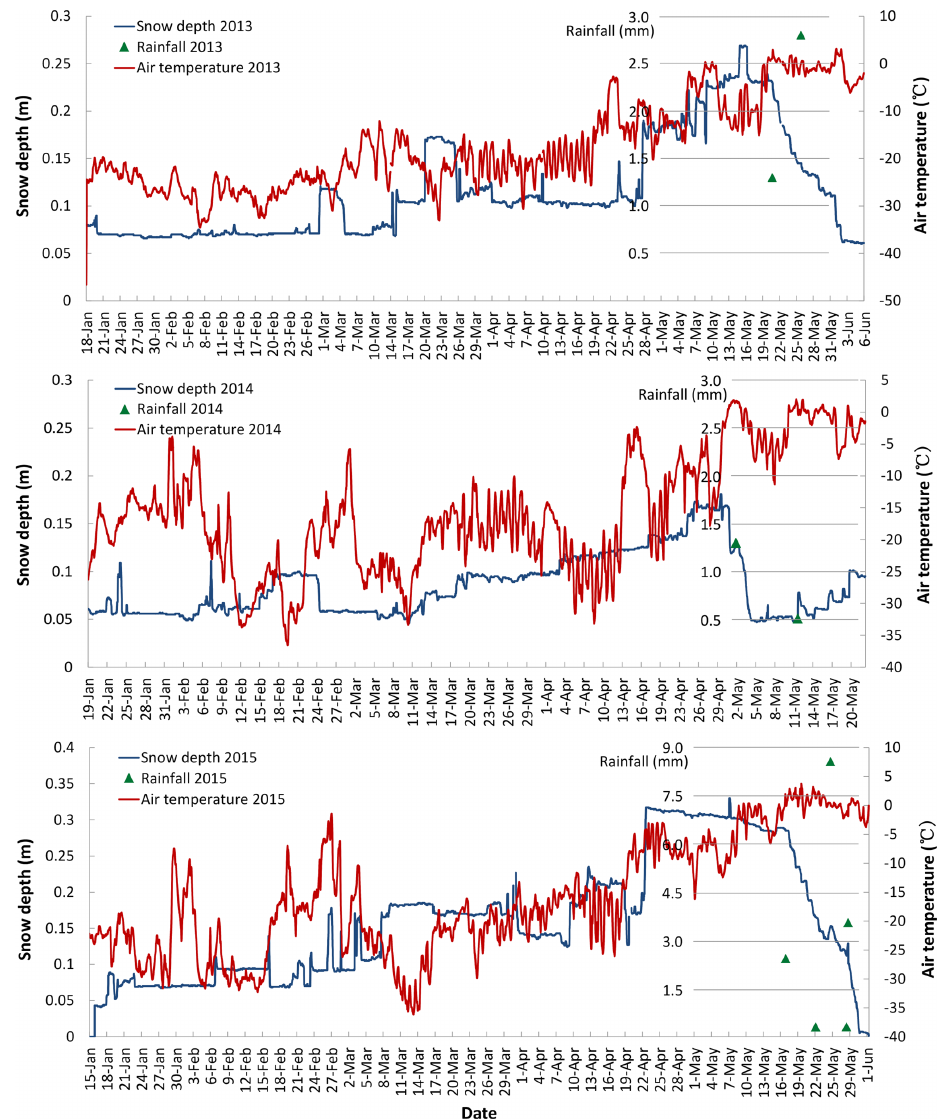
Figure 1. Rainfall and variations in air temperature and snow depth recorded near Utqia˙gvik, Alaska. The data were observed at the MB site on Chukchi Sea landfast ice between January and June in 2013, 2014 and 2015. Amount (mm w.e.) and timing of rainfall are indicated by blue